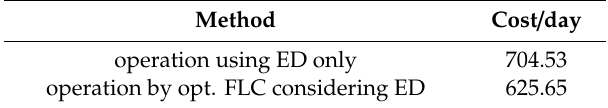
Table 9. Cost comparison between optimized FLC using ED and conventional ED